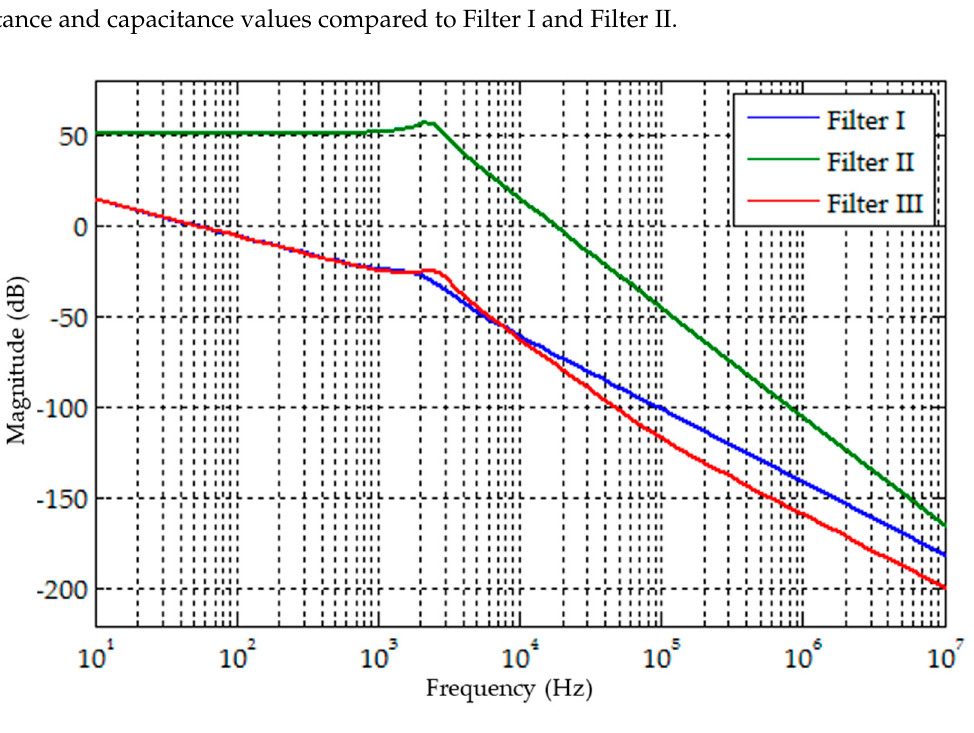
12 of 23 Table 1. System Design Parameters.